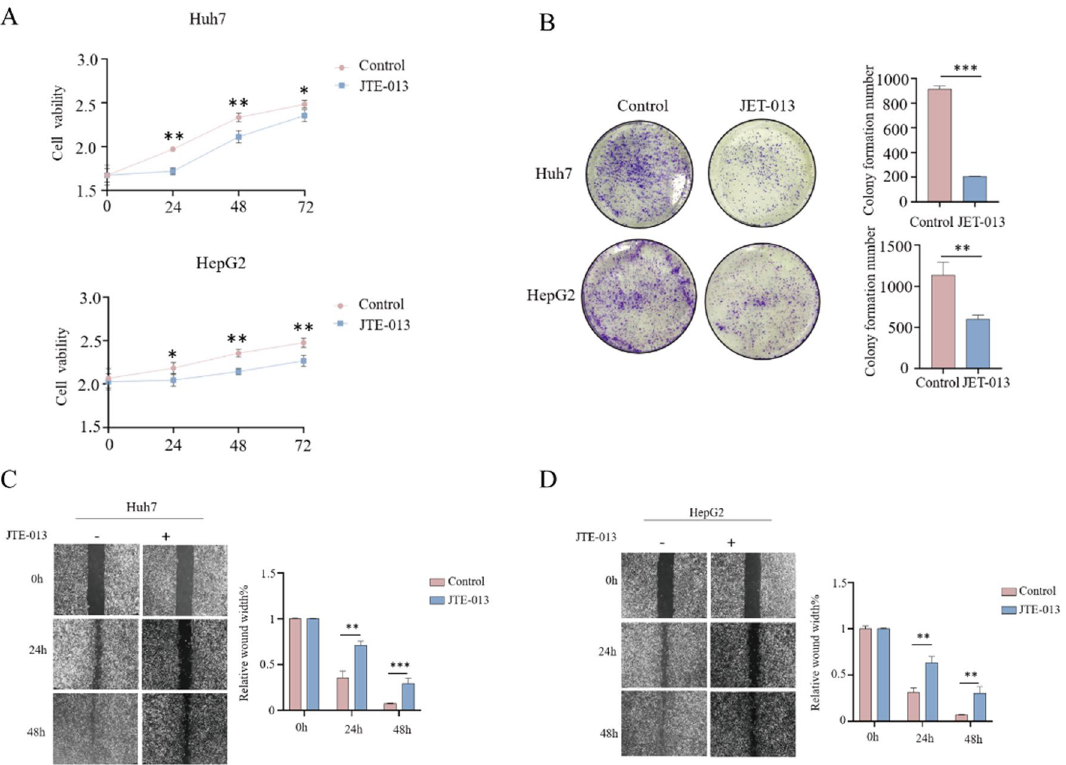
Fig. 5 Biological activity assay of HCC cells after antagonism of S1PR2 expression by JTE-013. A Cell activity measurement by the CCK8 assay; B cell clone formation assay; C , D cell scratch